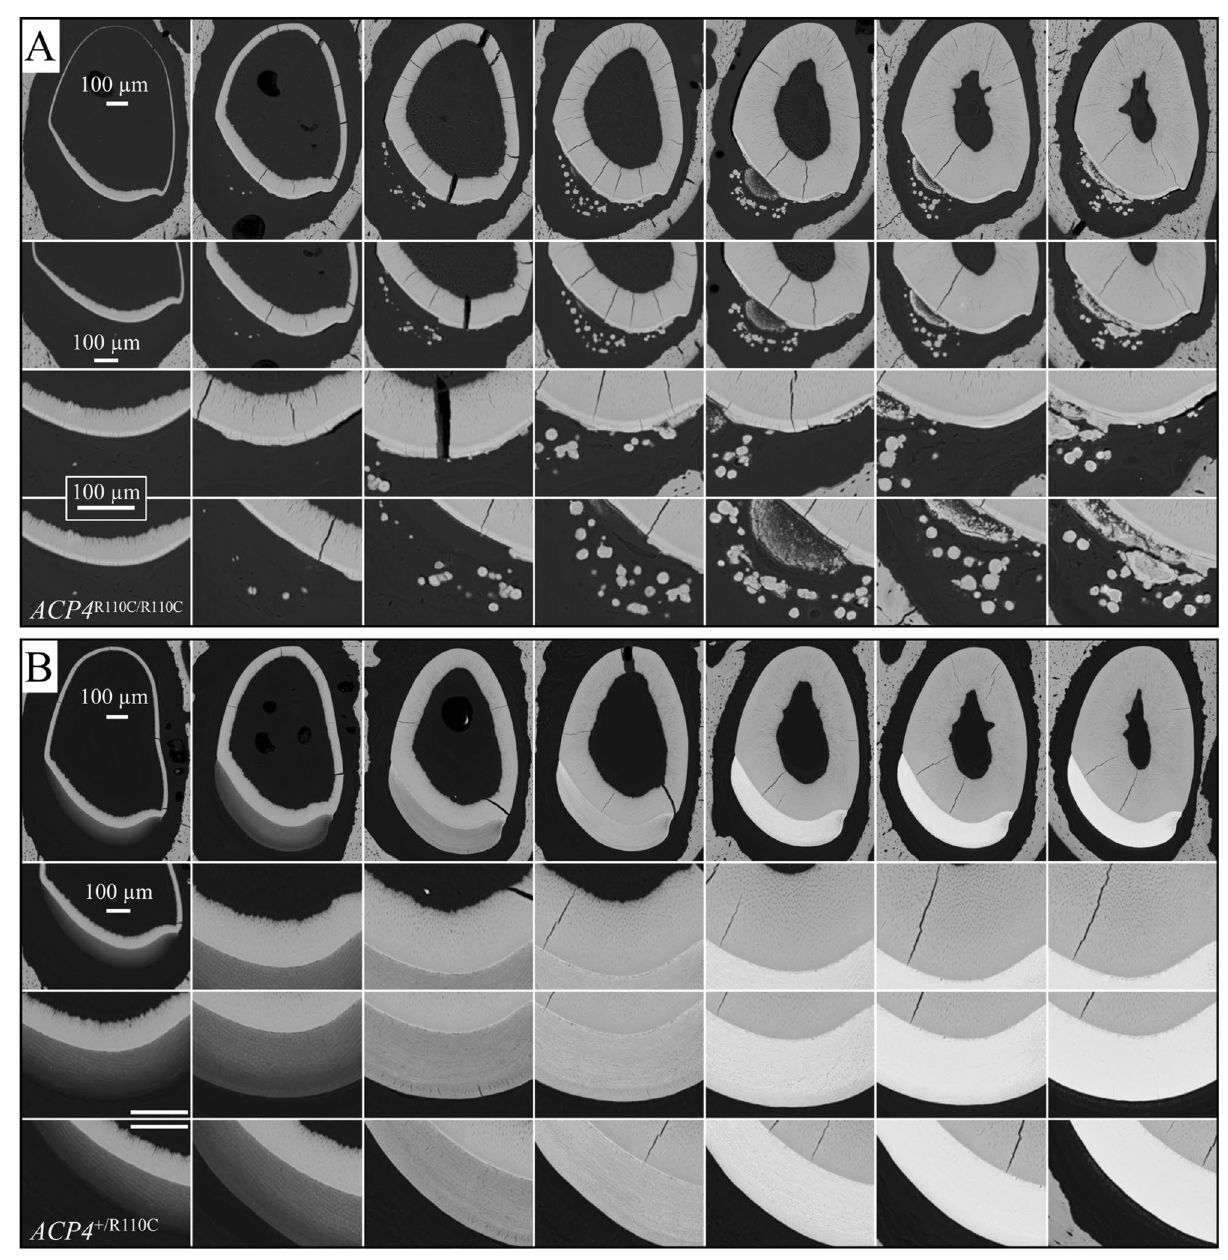
Figure 7. Backscattered SEM Images of Acp4 R110C/R110C and Acp4 +/+ 7-week Mandibular Incisors. The incisors were cross-sectioned at 1 mm increments (levels 2 through 8). The first two columns (levels 2 and 3) show the secretory stage of enamel formation, where the enamel mineral ribbons elongate to their full length and the enamel layer achieves its final thickness, contour, and rod/interrod organization. Columns 3 through 7 (levels 4 through 8) show enamel maturation, where the thin crystals deposited during the secretory stage grow in width and thickness and the enamel layer as a whole achieves its final degree of mineralization. ( A ) Acp4 R110C/R110C incisors have a thin, disorganized layer of mineralized material that forms on the surface of dentin, before cell pathology advances to the point where mineral is ectopically deposited within the cellular layer and grows into nodules that are often not attached to the enamel surface. In contrast, ( B ) the Acp4 +/R110C enamel appears to be totally normal, suggesting that half the normal amount of ACP4 enzyme is sufficient to avoid